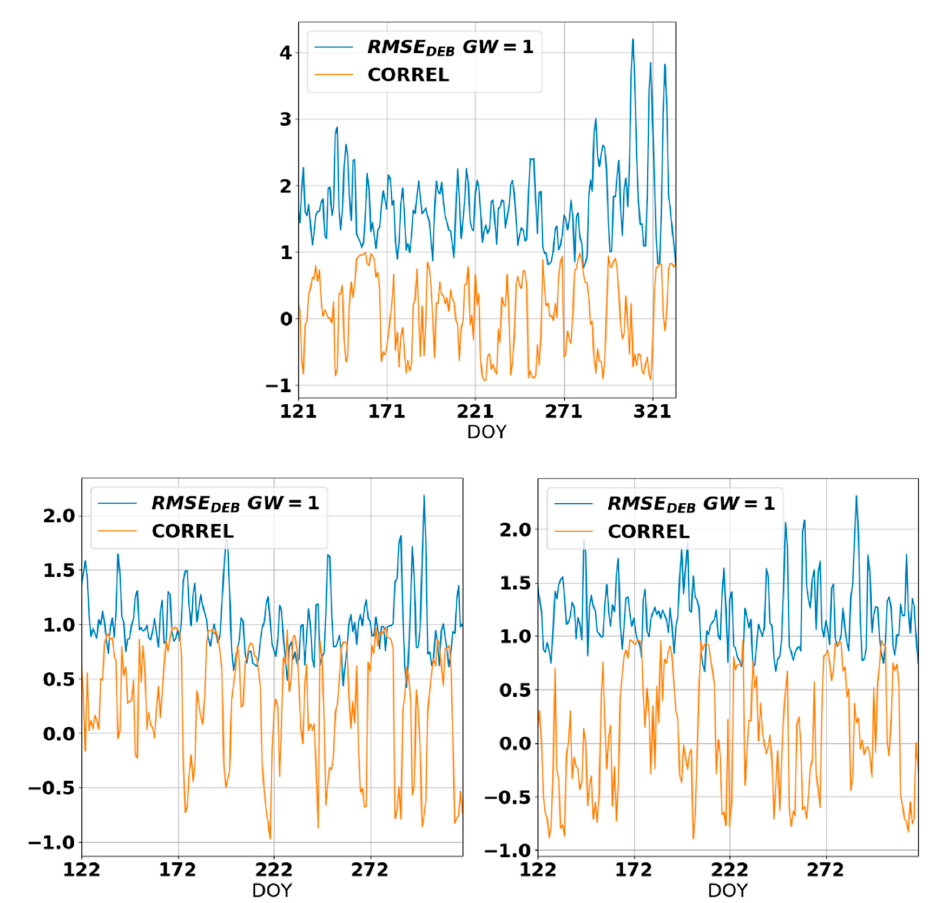
Figure 17. RMSE DEB for gap width = 1 and the correlation coefficient between the standard deviation of the observed data used for linear regression and RMSE DEB for Kikinda (Serbia; top left ), Bahariya (Egypt; top right ), Gumpenstein (Austria; middle ), Montecristo (Italy; bottom left ) and Pianosa (Italy; bottom right ).